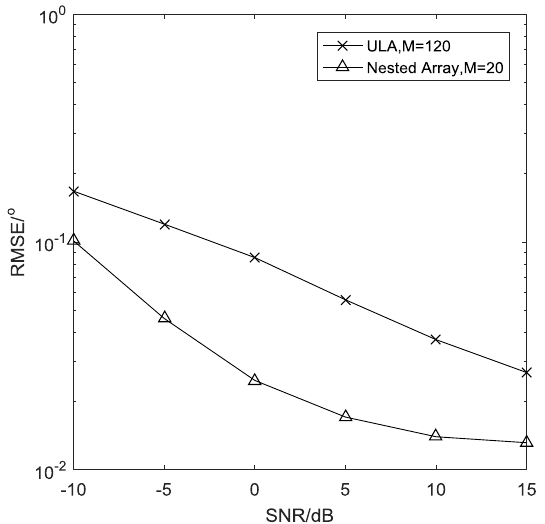
Figure 8. RMSE comparison of uniform linear array (ULA) and nested array.